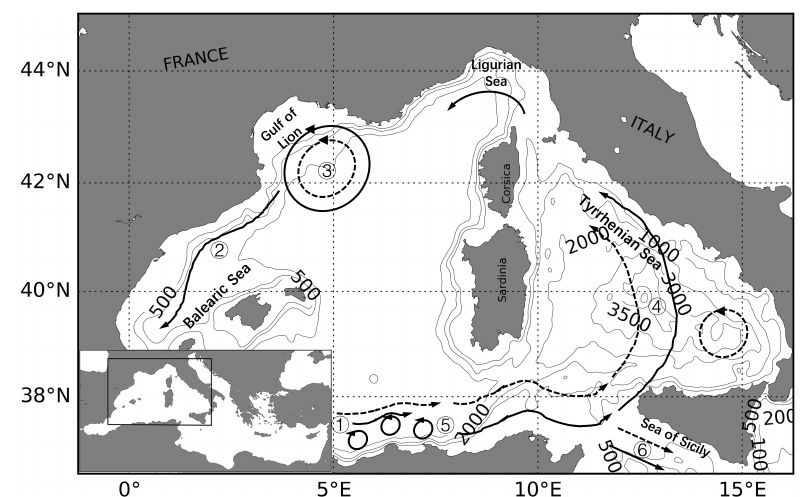
Figure 1. Map of main surface currents and eddies in the west Mediterranean Sea. Dashed arrows represent summer circulation, plain arrows represent winter circulation. 1 (cid:13) Western Alborán gyre; 2 (cid:13) Ligurian-Provençal current; 3 (cid:13) Lions Gyre; 4 (cid:13) Thyrrhenian cyclonic circulation with summer weakening and eastern anticyclone; 5 (cid:13) Algerian current and eddies; 6 (cid:13) Atlantic Ionian stream. Figure referenced from Pinardi and Masetti [17].